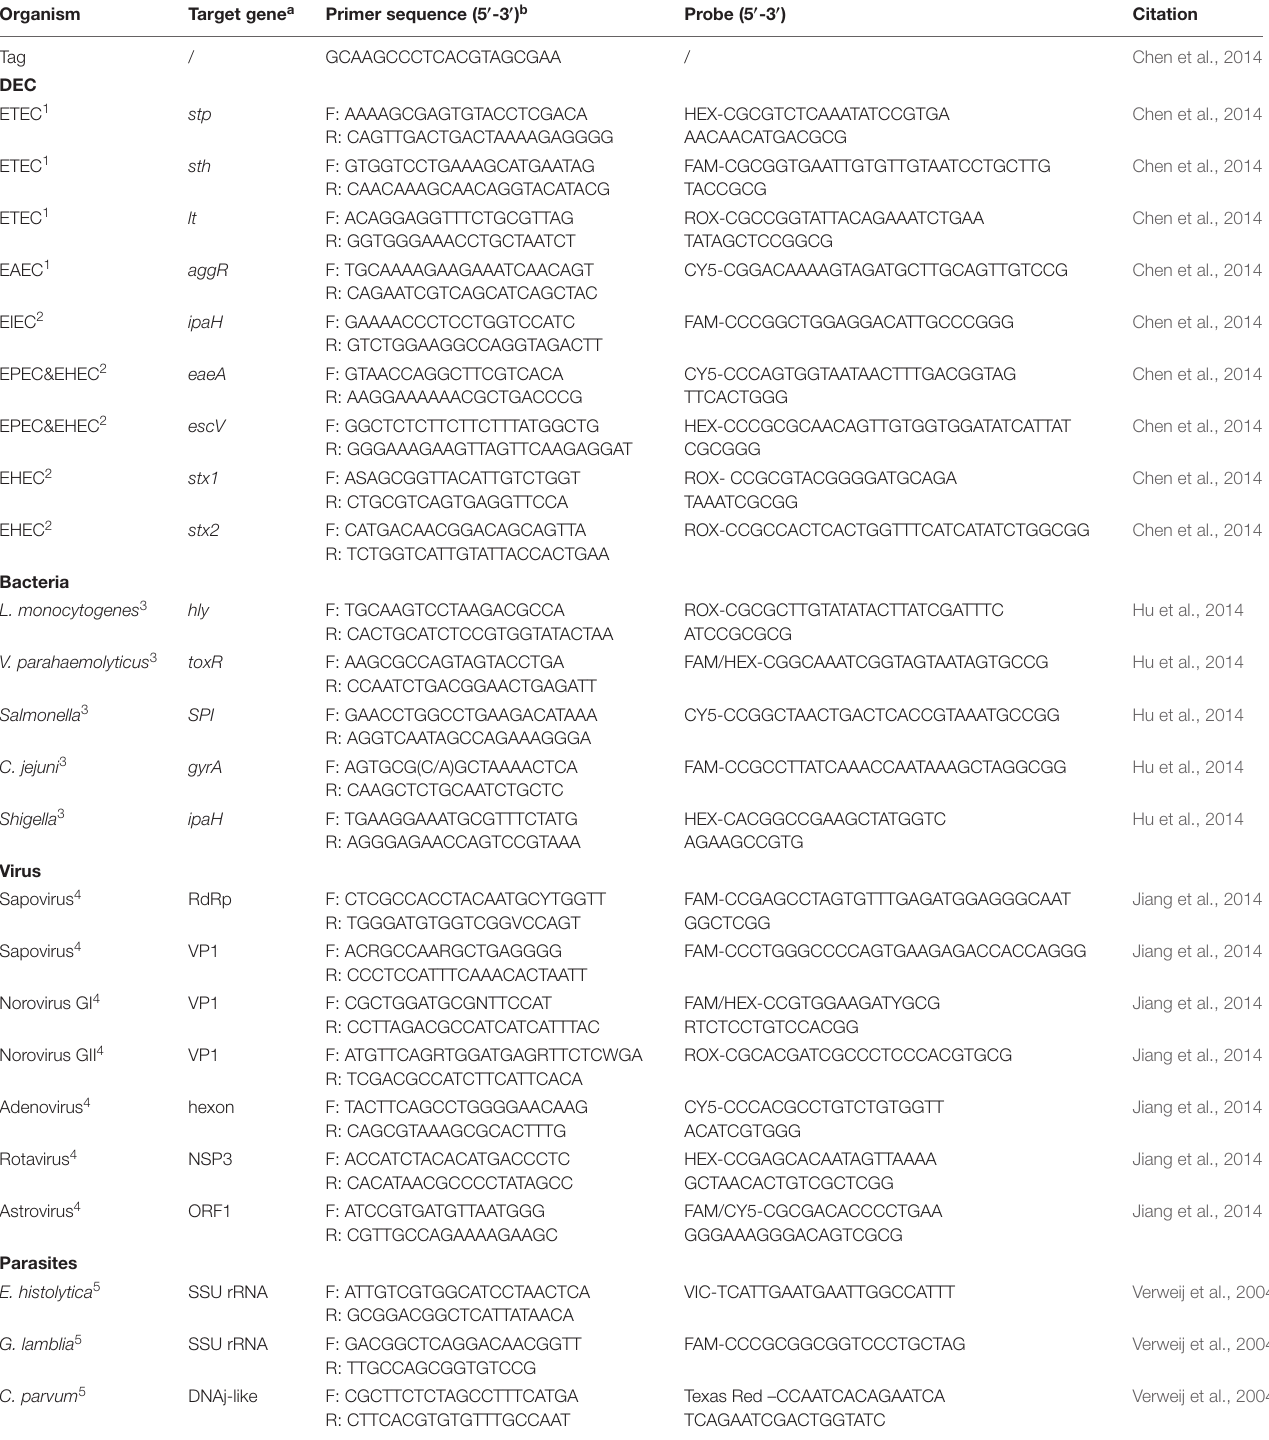
TABLE 1 | The oligonucleotide primers and probes for real-time PCR used in this study. Organism Target gene